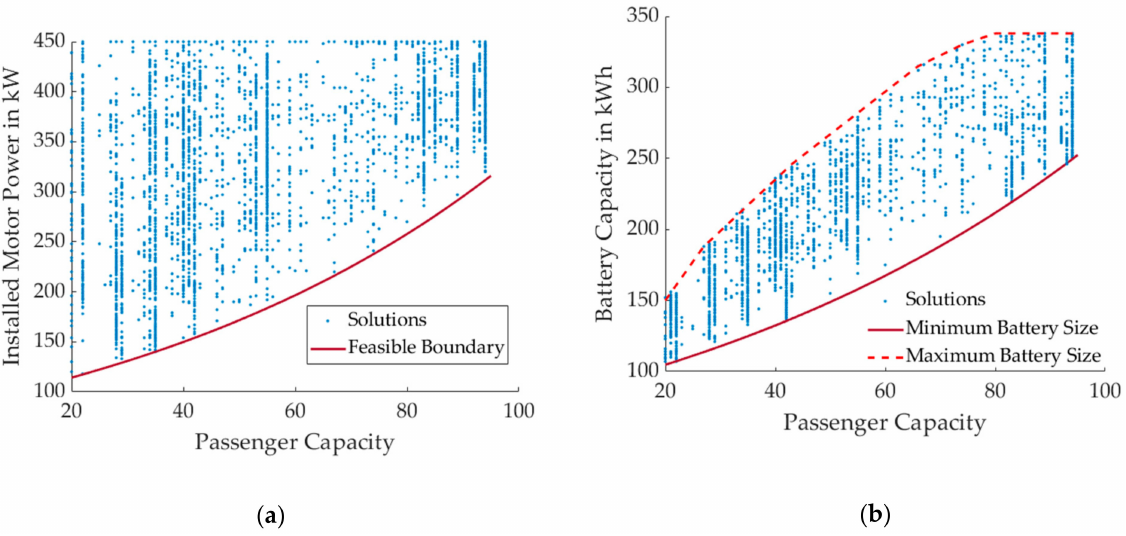
Figure 13. Shows the solution space and minimum required ( a ) motor power and ( b ) battery capacity. Figure 13b shows the minimum battery capacity required for different vehicle sizes. The minimum required battery size increases from 105 kWh for a 20-passenger vehicle to around 250 kWh for a 94-passenger vehicle for the depot charging strategy. The plot further shows the maximum battery size that can be installed and packaged in the vehicle due to the limited packaging space in the